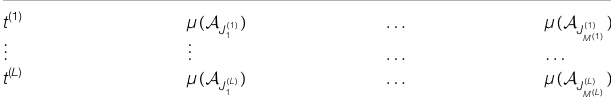
foratestcase t ( ℓ ) ,consistsofbene fi tvalues(measuredwith μ (cid:1) μ ( ℓ ) )thatcanbe achieved using milestone values C ( ℓ ) m in column m as cost